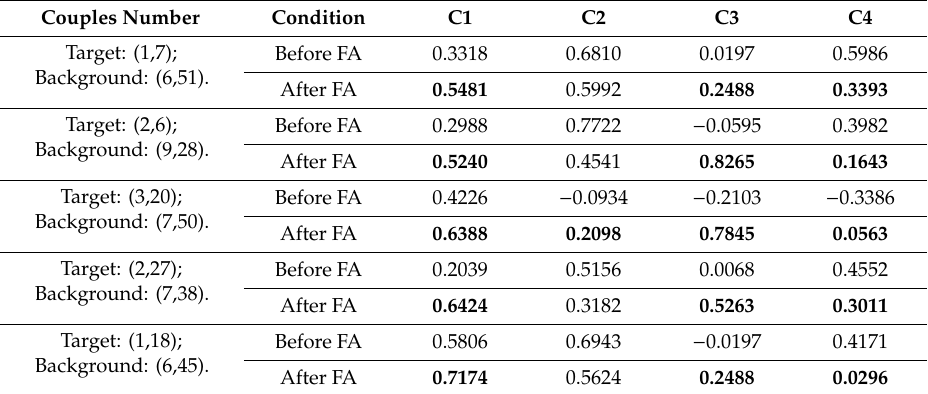
Table 7. Parts of correlation coe ffi cients before and after FA.